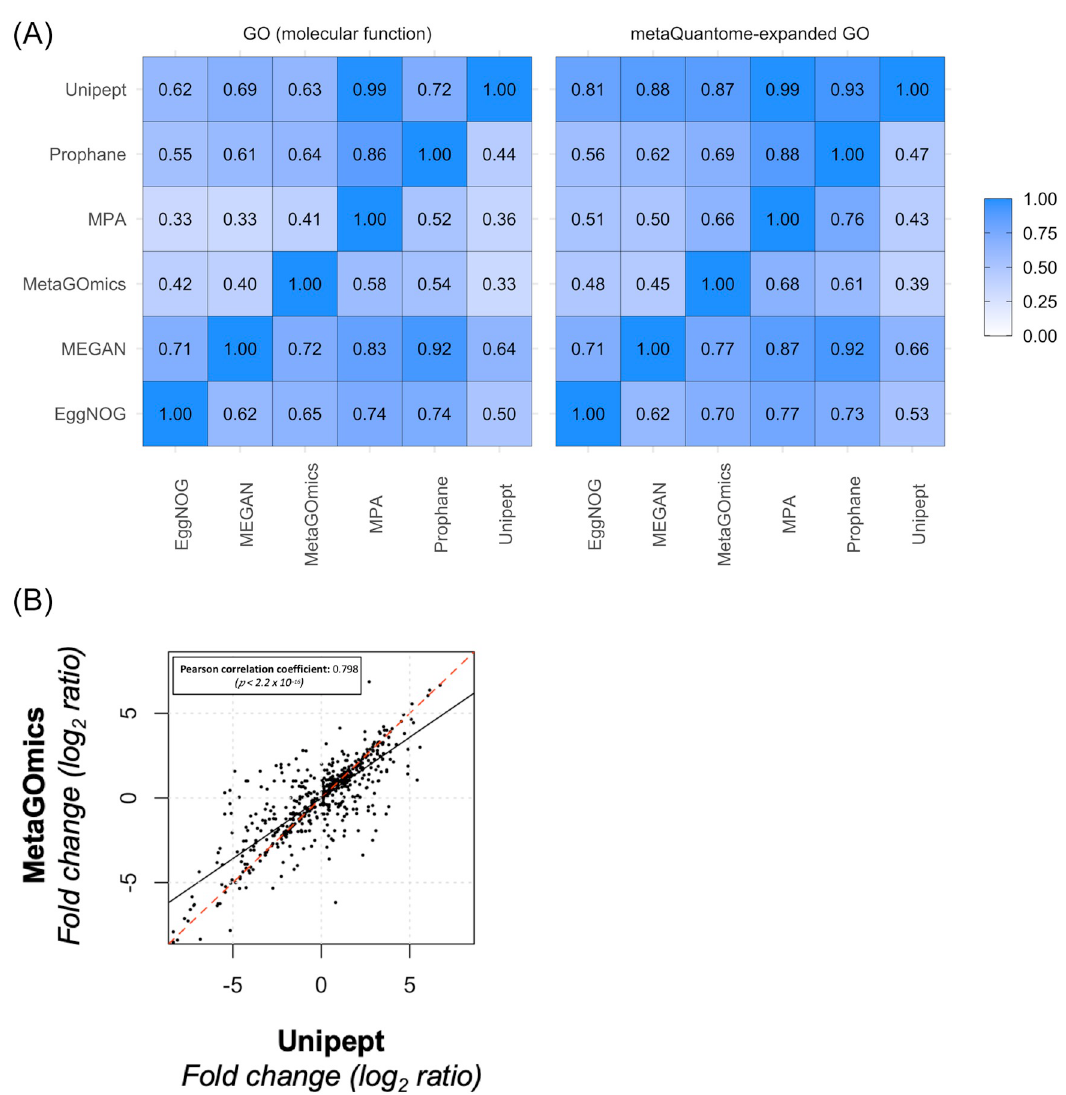
Fig 2. A) Qualitative and quantitative comparison of functional tools. Overlap of unique molecular function GO terms (left) and expanded GO terms (right) were compared amongst the six functional tools. Values were calculated as a fraction of the size of the term intersection (between the tools labeled on the column and row) over the total term size of the tool listed on the horizontal axis (column). Each functional analysis software tool was compared against each other. For example, for molecular function GO terms (left panel), 90% of the unique MPA term set is present in Unipept’s unique term set. For molecular function expanded GO terms, the overlap is much larger for all tools within Unipept (right panel’s top row). B) Comparison of quantitative expression for molecular function GO terms from Unipept and MetaGOmics. Log2ratio of spectral counts ‘with sugar sample’ (WS) against ‘no sugar sample’ (NS) was calculated for MetaGOmics- and Unipept-generated molecular function GO terms. Unipept identified 1,109 molecular function GO terms, while MetaGOmics identified 900 molecular function GO terms. The data points in the figure represent quantitative values for 460 molecular function GO terms that overlapped between Unipept and